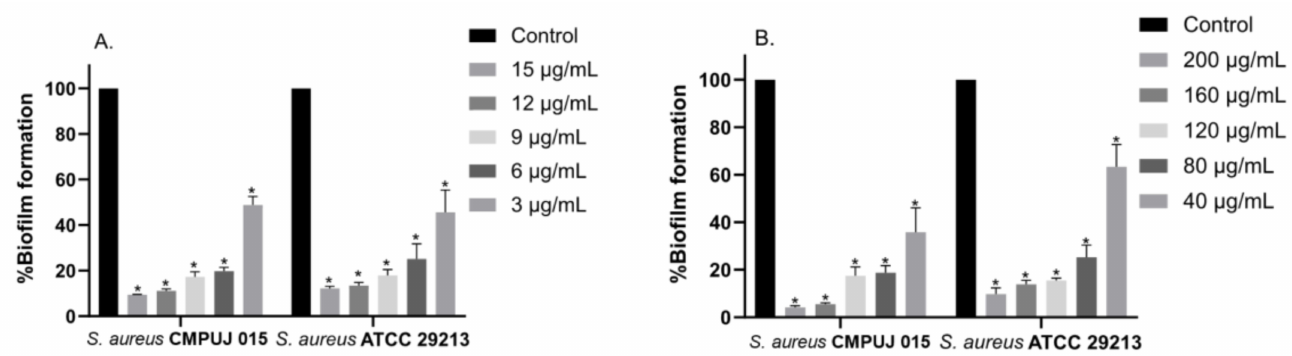
Figure 2. Antibiofilm effect on S. aureus CMPUJ 015 and S. aureus ATCC 29213 by ( A ) FMA30, ( B ) FME30. Data are represented as mean ± SD. ANOVA was used to show statistically significant differences compared to control (* p <